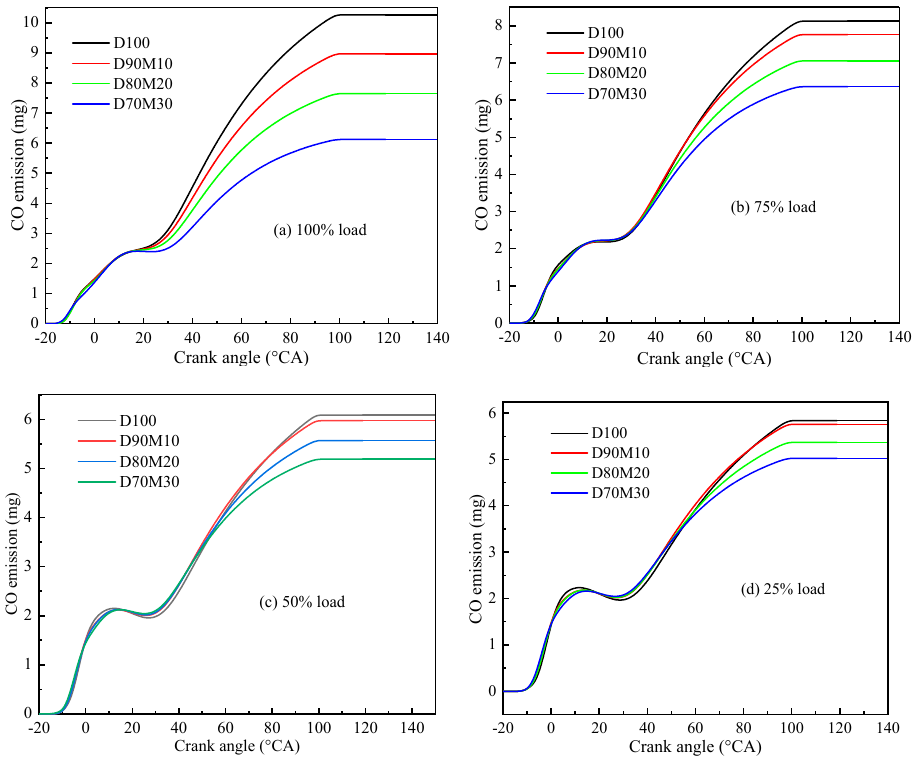
Figure 14. CO emission curves of different proportions of diesel–methanol blended fuel under different load conditions. ( a ) at 100% load, ( b ) at 75% load, ( c ) at 50% load, ( d ) at 25% load.